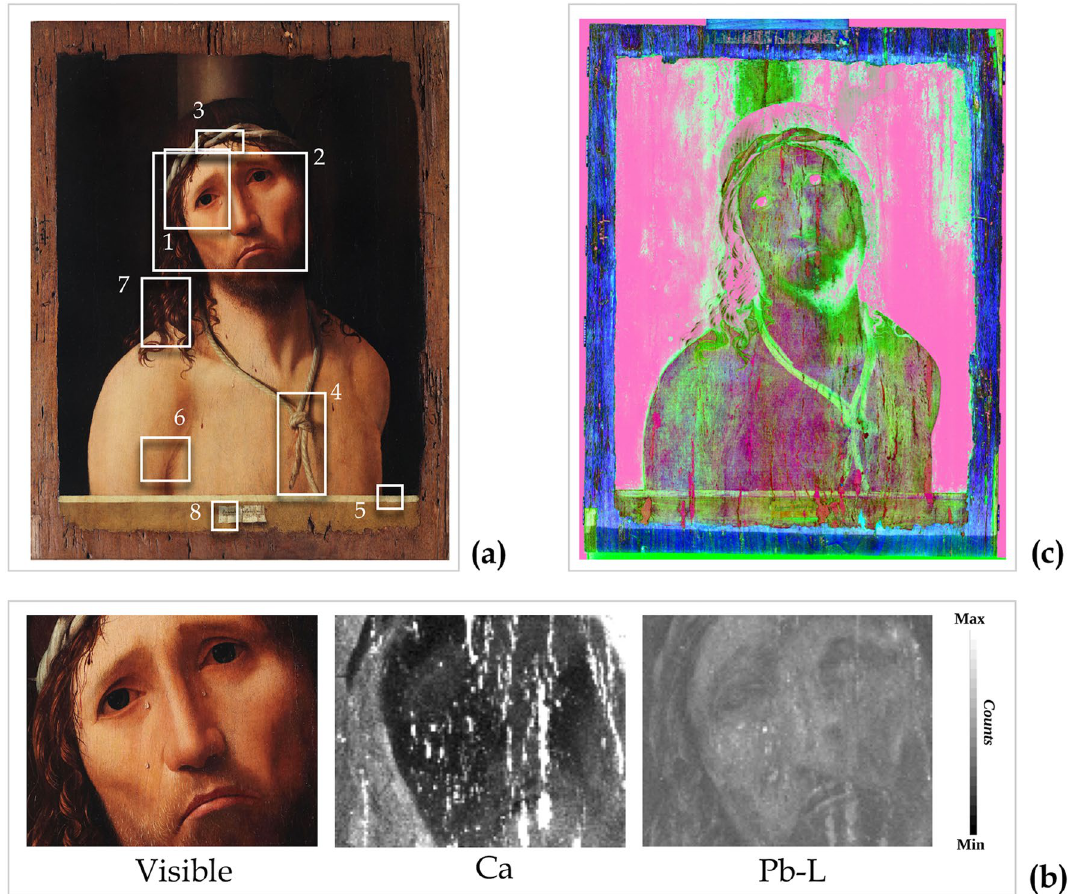
Figure 5. Studies of the underneath layers. ( a ) Visible picture of the painting and the eight areas analysed by X-ray fluorescence (MA-XRF). ( b ) Visible detail and MA-XRF elemental distribution maps of Ca and Pb-L of the visage area (13 × 10.3 cm). These results suggest the presence of preparation layers, composed of a Ca-based material and lead white. Note that the Ca distribution also highlights retouches and/or pictorial detachments. (c) Hyperspectral imaging (HSI) analysis. False-colour image obtained from the derivative cube of the short- wave infrared range (SWIR) HSI data (R = 1386 nm; G = 1479 nm; B = 1520 nm). The greenish areas map the gypsum and lead white distribution in the underneath